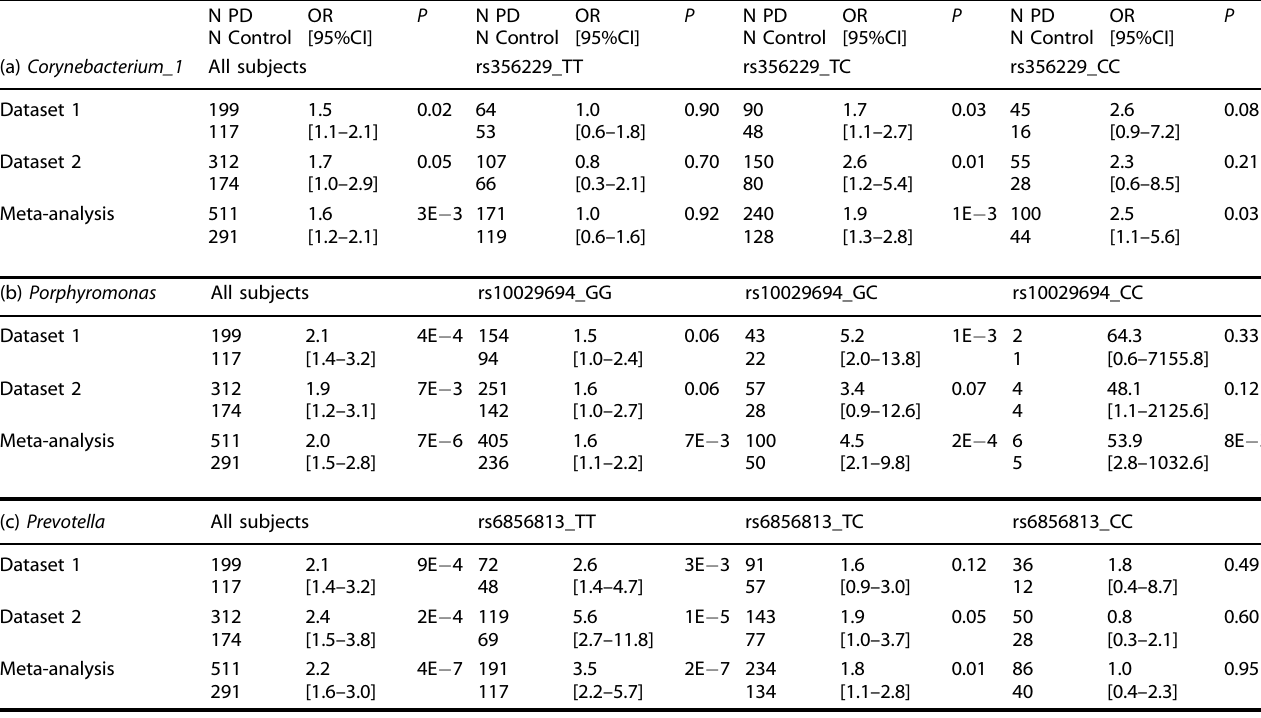
Table 1. Strati fi ed analyses suggest increased abundance of opportunistic pathogens in PD gut microbiome is dependent on the host